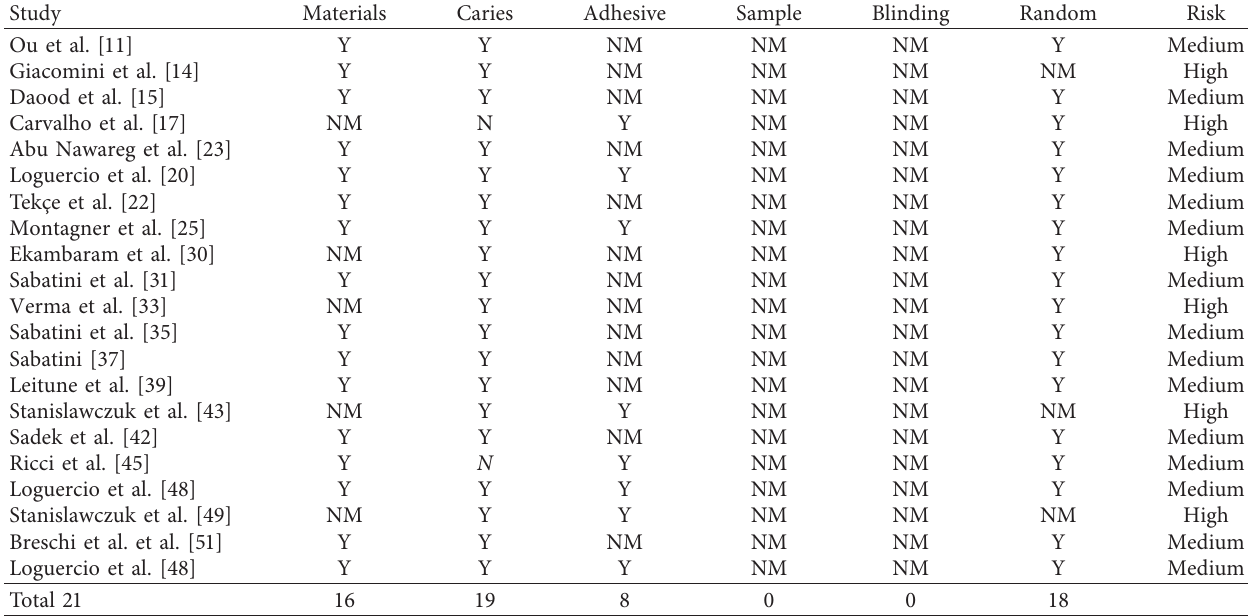
Figure 3: Forest plots of studies after 6, 12, and 24 months of aging. (a) Chlorhexidine (CHX) vs. control at six months. The N for both groups was 339 samples. The total random effect SMD was 0.907 (CI 95% 0.517; 1.297). The difference was statistically significant ( t � 4.568, P < 0 . 001). The I 2 was 82.11%. (b) CHX vs. control after 12 month aging. The N for both groups was 173 samples. The total random effect SMD was 0.821 (CI 95% 0.367; 1.275). The difference was statistically significant ( t � 3.557, P < 0 . 001). The I 2 was 74.97%. (c) CHX vs. control after 24-month aging. The N for both groups was 40 samples. The total random effect SMD was 2.168 (CI 95% 1.627; 2.708). The difference was statistically significant ( t � 7.982, P < 0 . 001). The I 2 was 0.00%. Table 2: Factors associated with the risk of bias in different